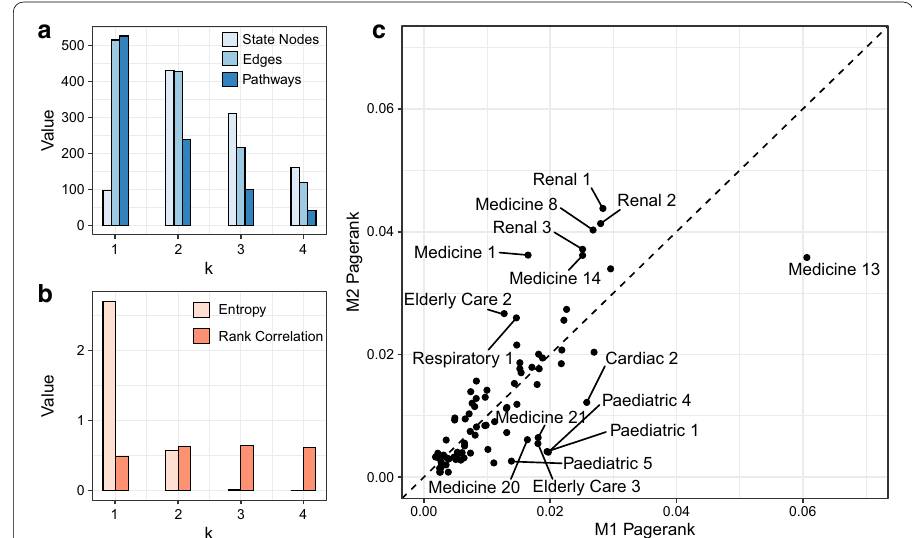
Fig. 3 A comparison of the effect of memory for models of order k . ( a ) Details of network size (no. state nodes, edges) and data (no. trajectories) for k = 1,2,3,4 . ( b ) The entropy of each higher order memory network and the rank correlation between train and validation sets. ( c ) PageRank of wards for M 1 and M 2 , dashed line indicating equality of